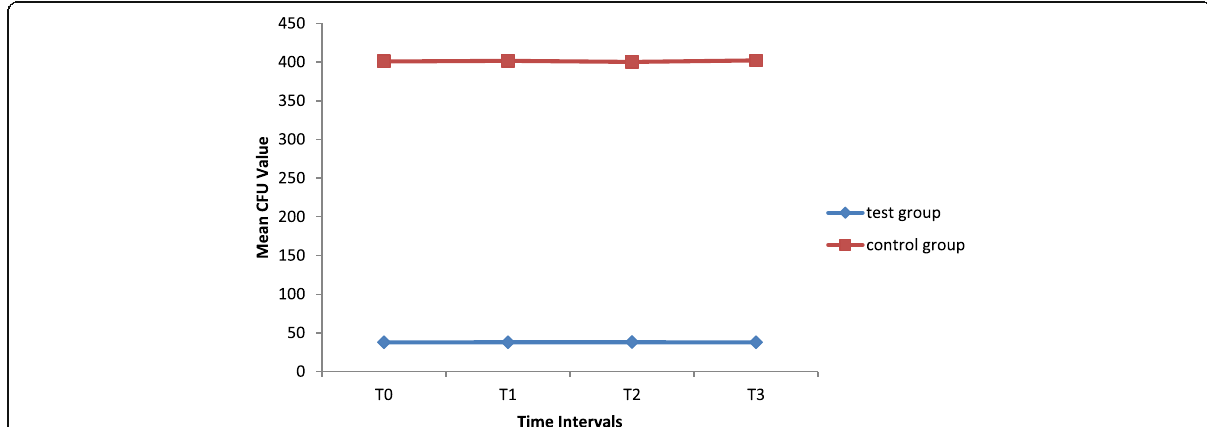
Fig. 1 Colony count in the control group (normal stainless steel bracket) and test group (bracket coated with the N-doped TiO2). T0 (24 h), T1 (30 days), T2 (60 days), T3 (90